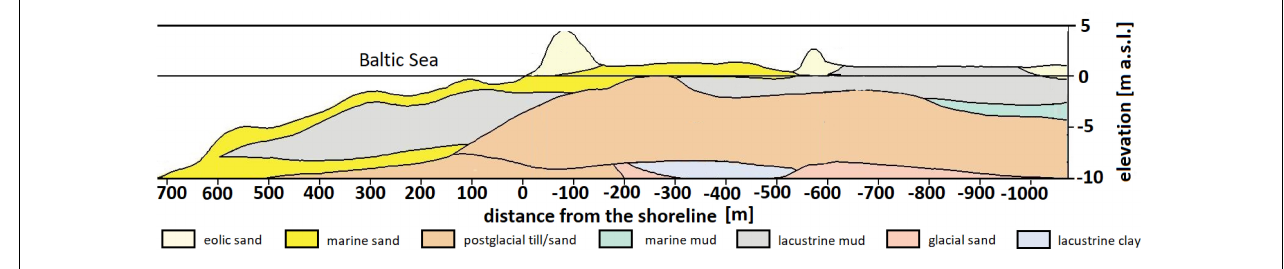
FIGURE 4 | Lake Bukowo barrier cross-section at km 288.3 [after U´scinowicz et al. (2007c)].